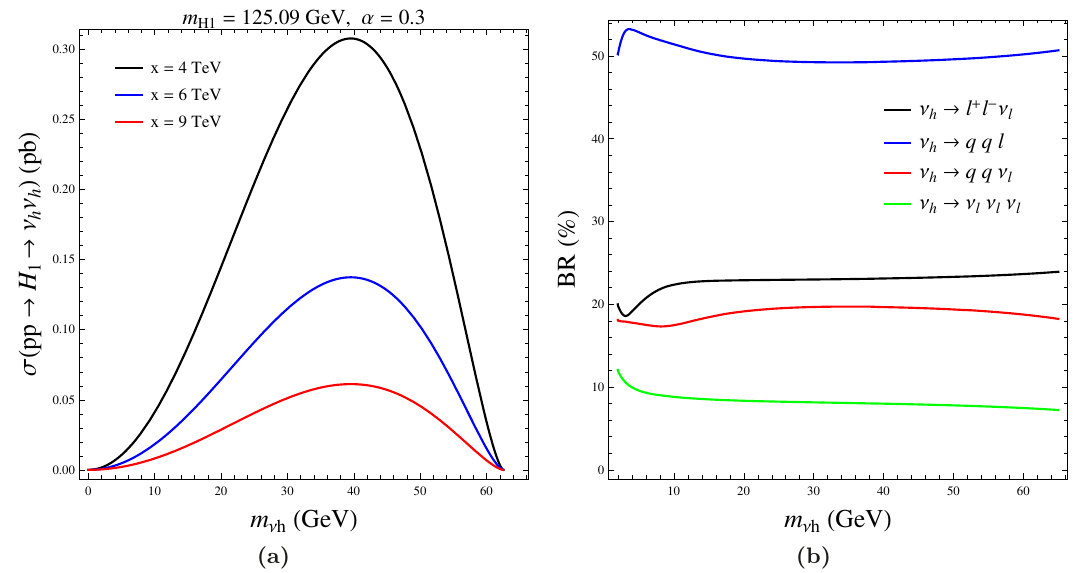
Figure 3. (a) σ BR for the process pp H 1 ν h ν h at the LHC, for 13 TeV proton-proton colli- × → → sions as a function of the heavy RH neutrino mass. From top to bottom, the three curves display the cross section for three different values of the VEV of the heavier Higgs: x = 4, 6, 9 TeV. The Higgs mixing angle is set to be α = 0.3. (b) Heavy neutrino branching ratios as a function of its